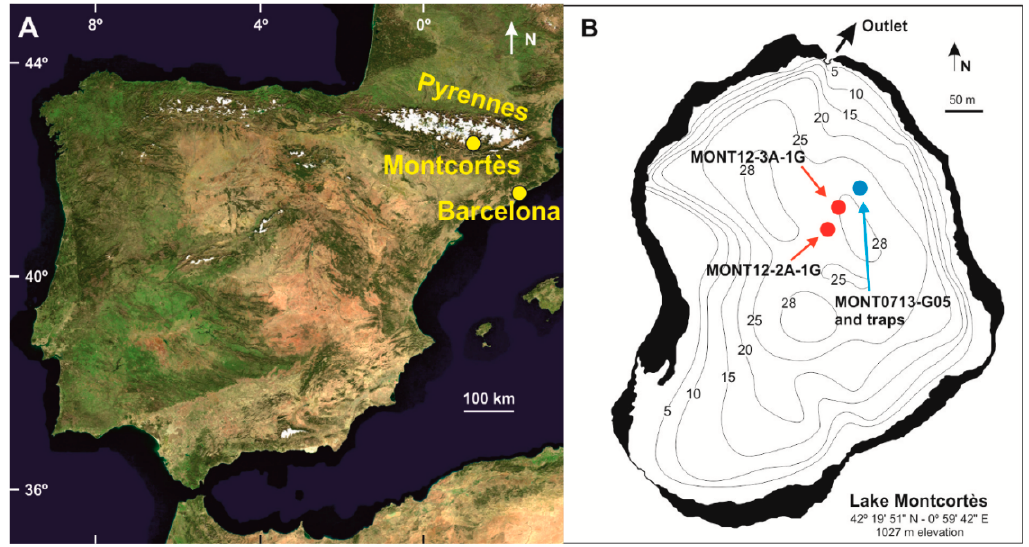
Figure 1. ( A ) Location of Lake Montcortès in the Pyrenean mountain range (NE Iberian Peninsula). ( B ) Bathymetric map with position of the cores and the traps.